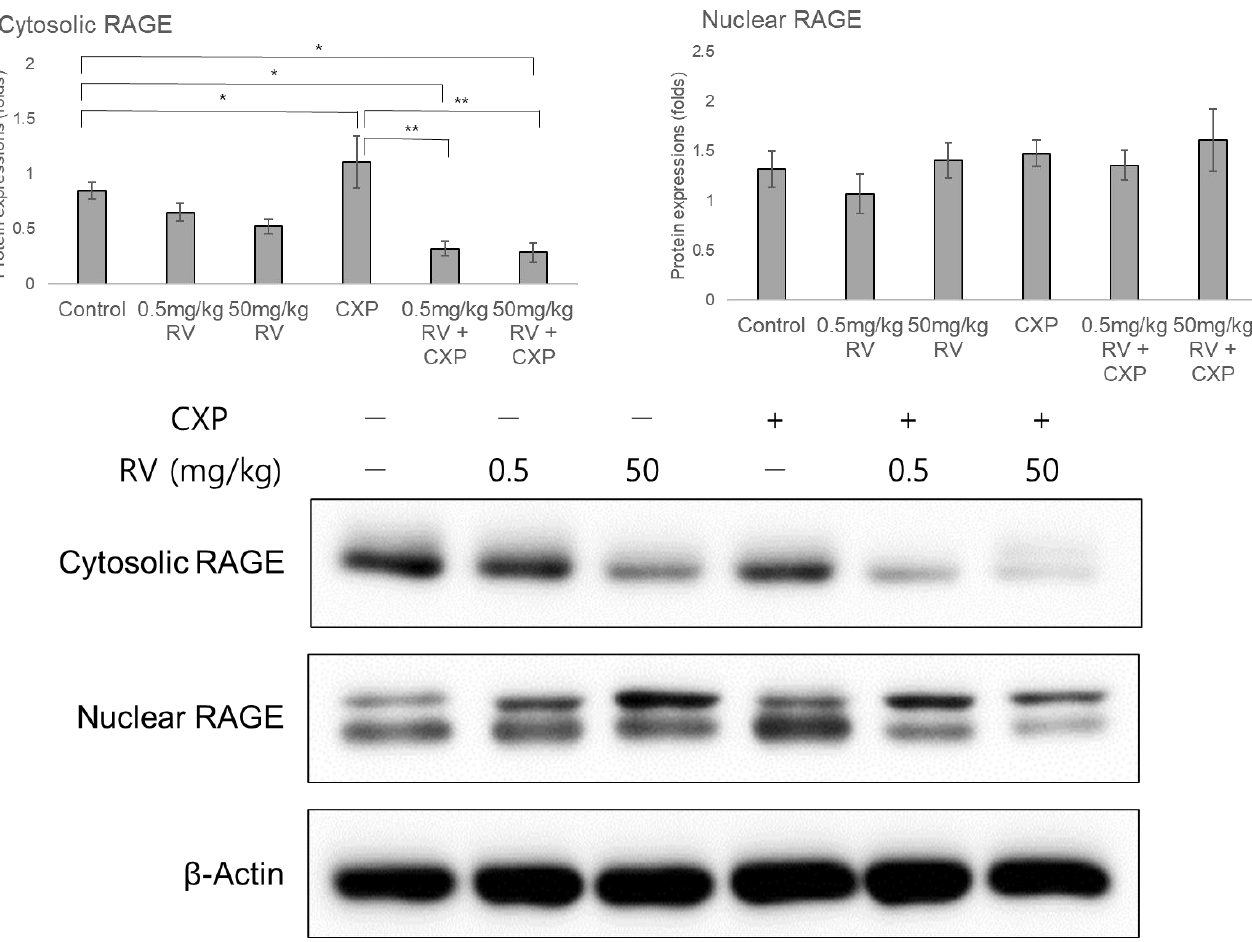
Figure 5. Cytosolic RAGE protein level decreased following administration of a 50 mg/kg of resveratrol (RV). Both 0.5 mg/kg RV + CXP and 50 mg/kg RV + CXP groups showed lower cytosolic RAGE protein levels compared to the control group. (* p < 0.05, compared to the control group, ** p < 0.05, compared to the CXP group)